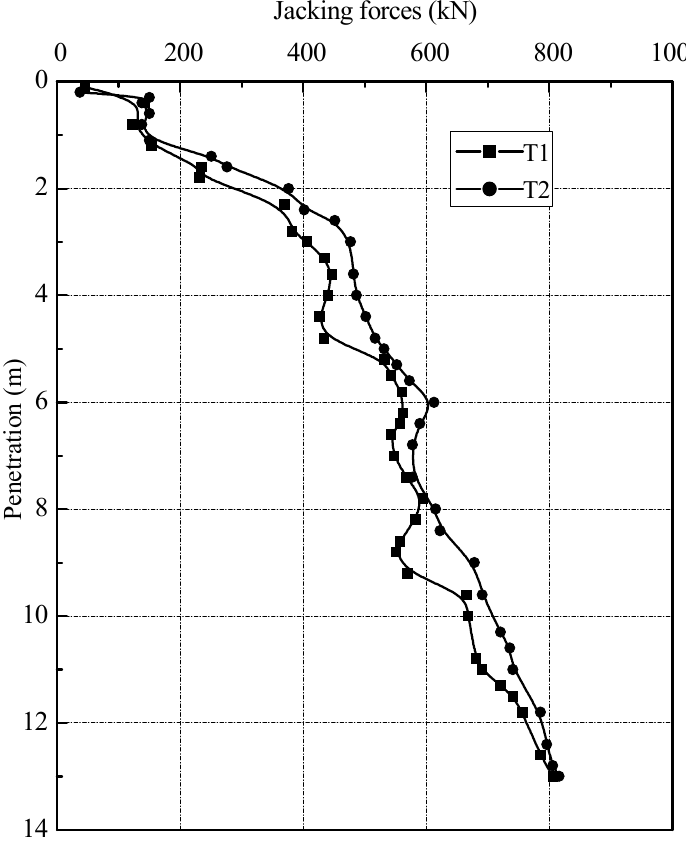
Figure 7. Jacking forces versus penetration depth.